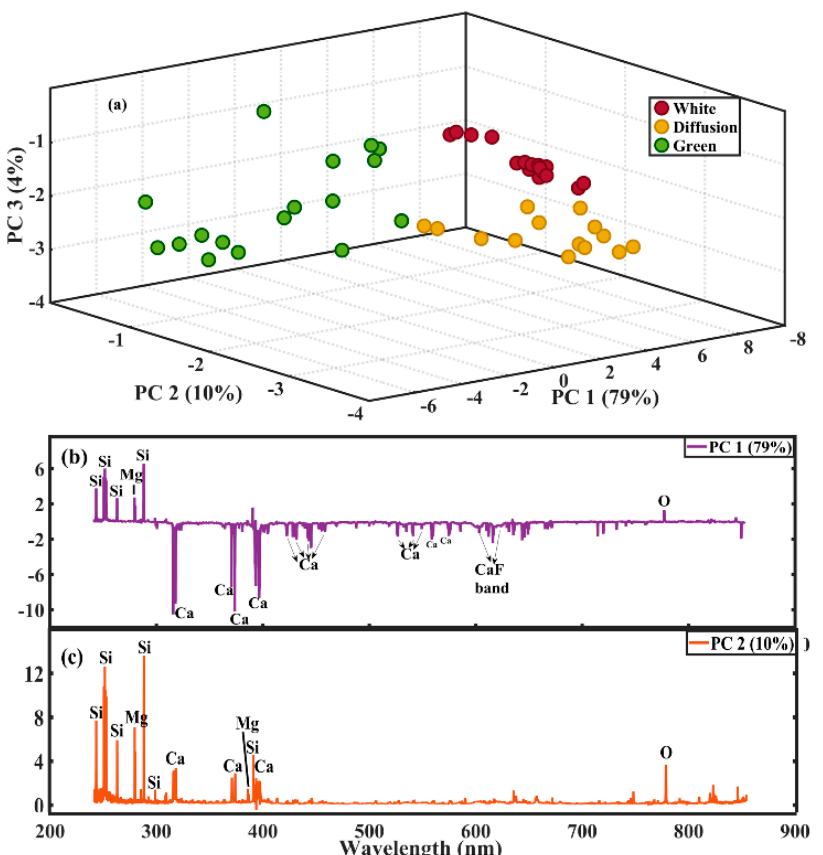
Figure 10. The PCA plots of the LIBS data of quartz-fluorite sample representing ( a ) score plot for white (red circles), diffusion (yellow circles), and green zones (green circles) in the wavelength range of 240–800 nm, ( b ) loading plot of PC1, and ( c ) loading plot of PC2 that demonstrates which spectral lines describes variance.